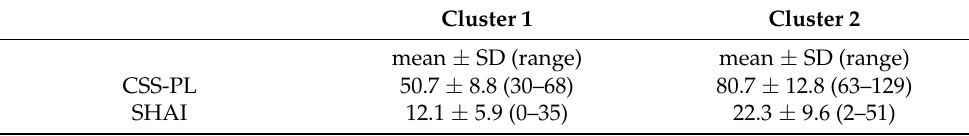
Figure 1. Results of k-means cluster analysis. Table 1. General characteristics of the emerged clusters based on CSS-PL and SHAI total